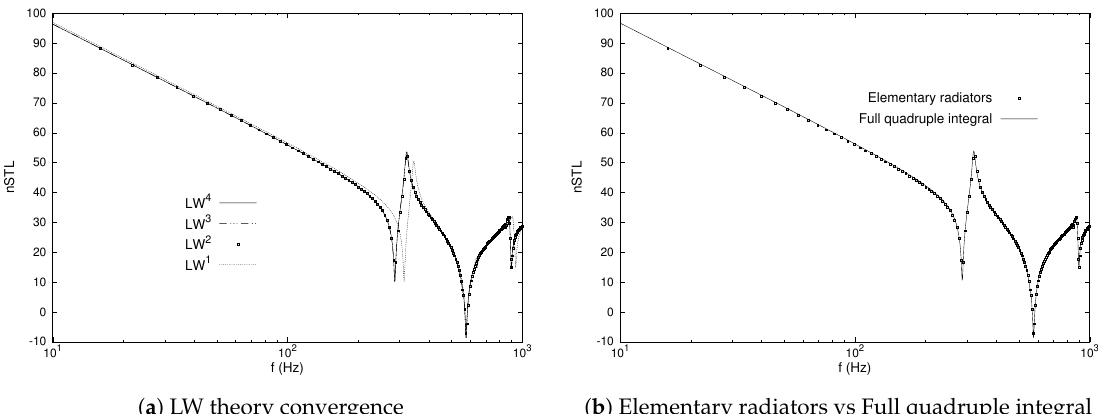
Figure 4. Simply-supported rectangular cylindrical shell with R α = 1 m. Normal incidence sound transmission levels ( nSTL ) . Study of the layer-wise expansion order convergence, and comparison of the full quadruple integral and elementary radiators